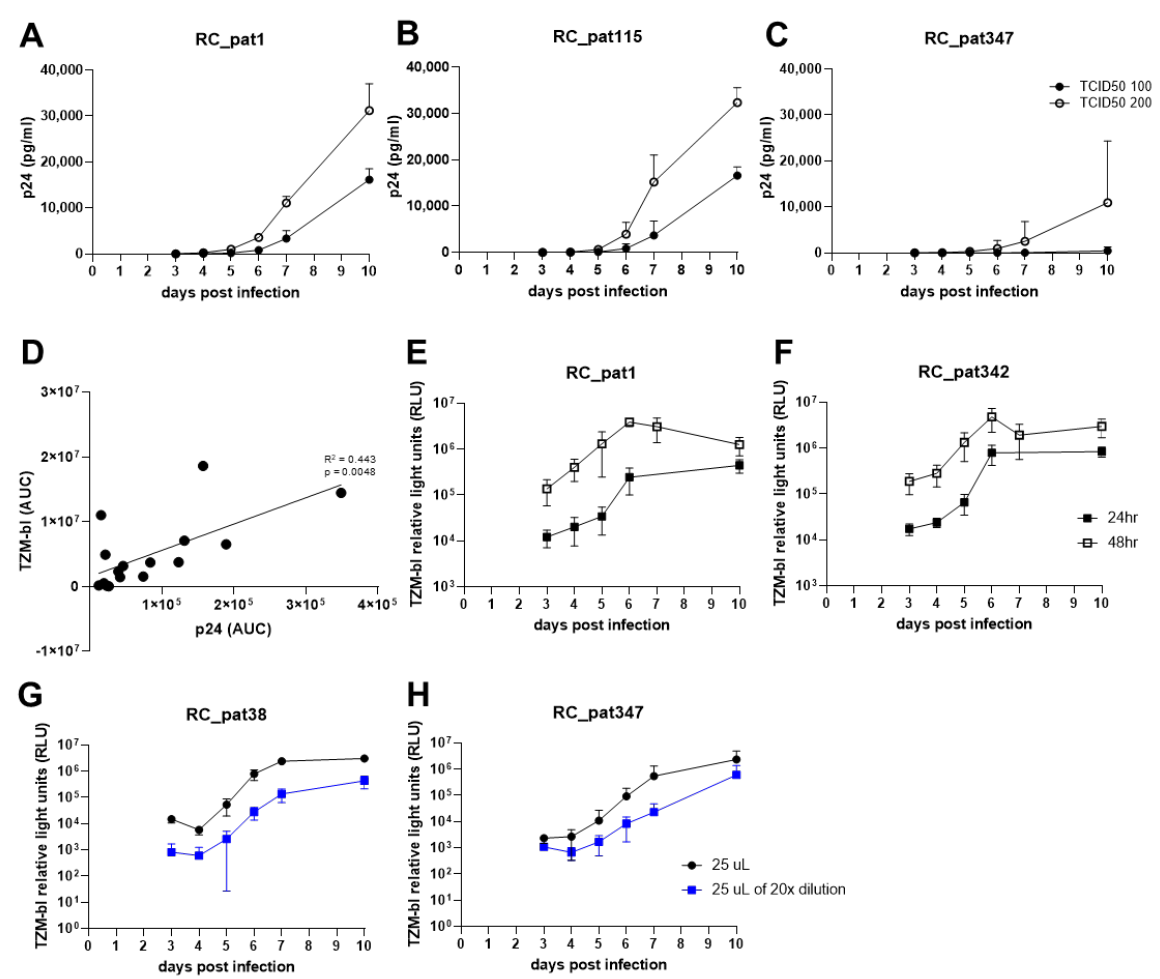
Figure 2. The optimization experiments for establishment of the replication capacity assay. ( A – C ) The graphs depict the replication kinetics comparison between infection with TCID 50 100 and 200 for three primary HIV-1 isolates. The x-axis represents the days post infection, and the y-axis represents p24 antigen value (pg/mL) measured by p24 ELISA in linear-scale. ( D ) The scatterplot compares AUC values obtained from two separate quantifying methods. The x-axis represents the AUC values obtained by quantifying p24 antigen. The y-axis represents the AUC values obtained from quantifying TZM-bl luciferase expression. An OLS regression line is shown (black line). Both axes are in linear-scale. ( E , F ) The graphs show TZM-bl luciferase expression measured 24 h (closed black square) or 48 h (open black square) after culture supernatant transfer to TZM-bl cells. The x-axis represents the days post infection, and the y-axis represents the TZM-bl luciferase expression measured by relative light units (RLU). ( G , H ) The graphs depict the comparison of different viral input amounts onto TZM-bl cells in log-scale. The x-axis represents the days post infection, and the y-axis represents the TZM-bl luciferase expression measured by relative light units (RLU) in log-scale.